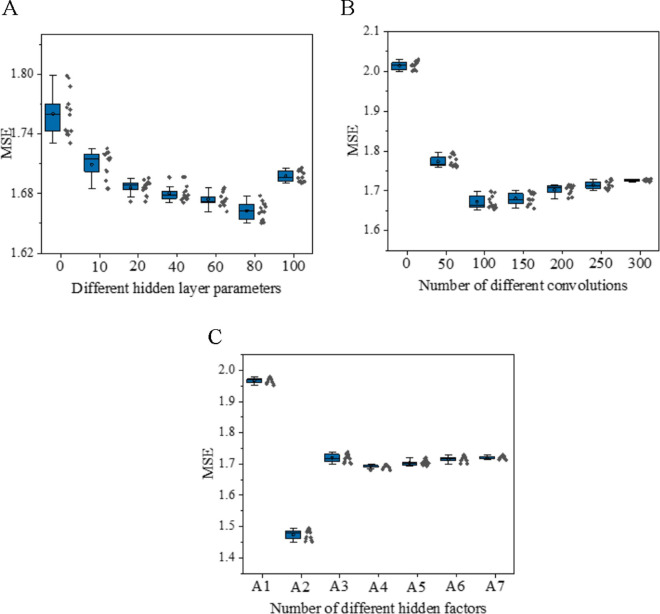
Impact of different model parameters on prediction results.A1 is 25 hidden layers, A2 is 50 hidden layers, A3 is 100 hidden layers, A4 is 50 first hidden layers + 25 second hidden layers, A5 is 100 first hidden layers + 50 second hidden layers, A6 is 100 first hidden layers + 50 second hidden layers + 25 third hidden layers.